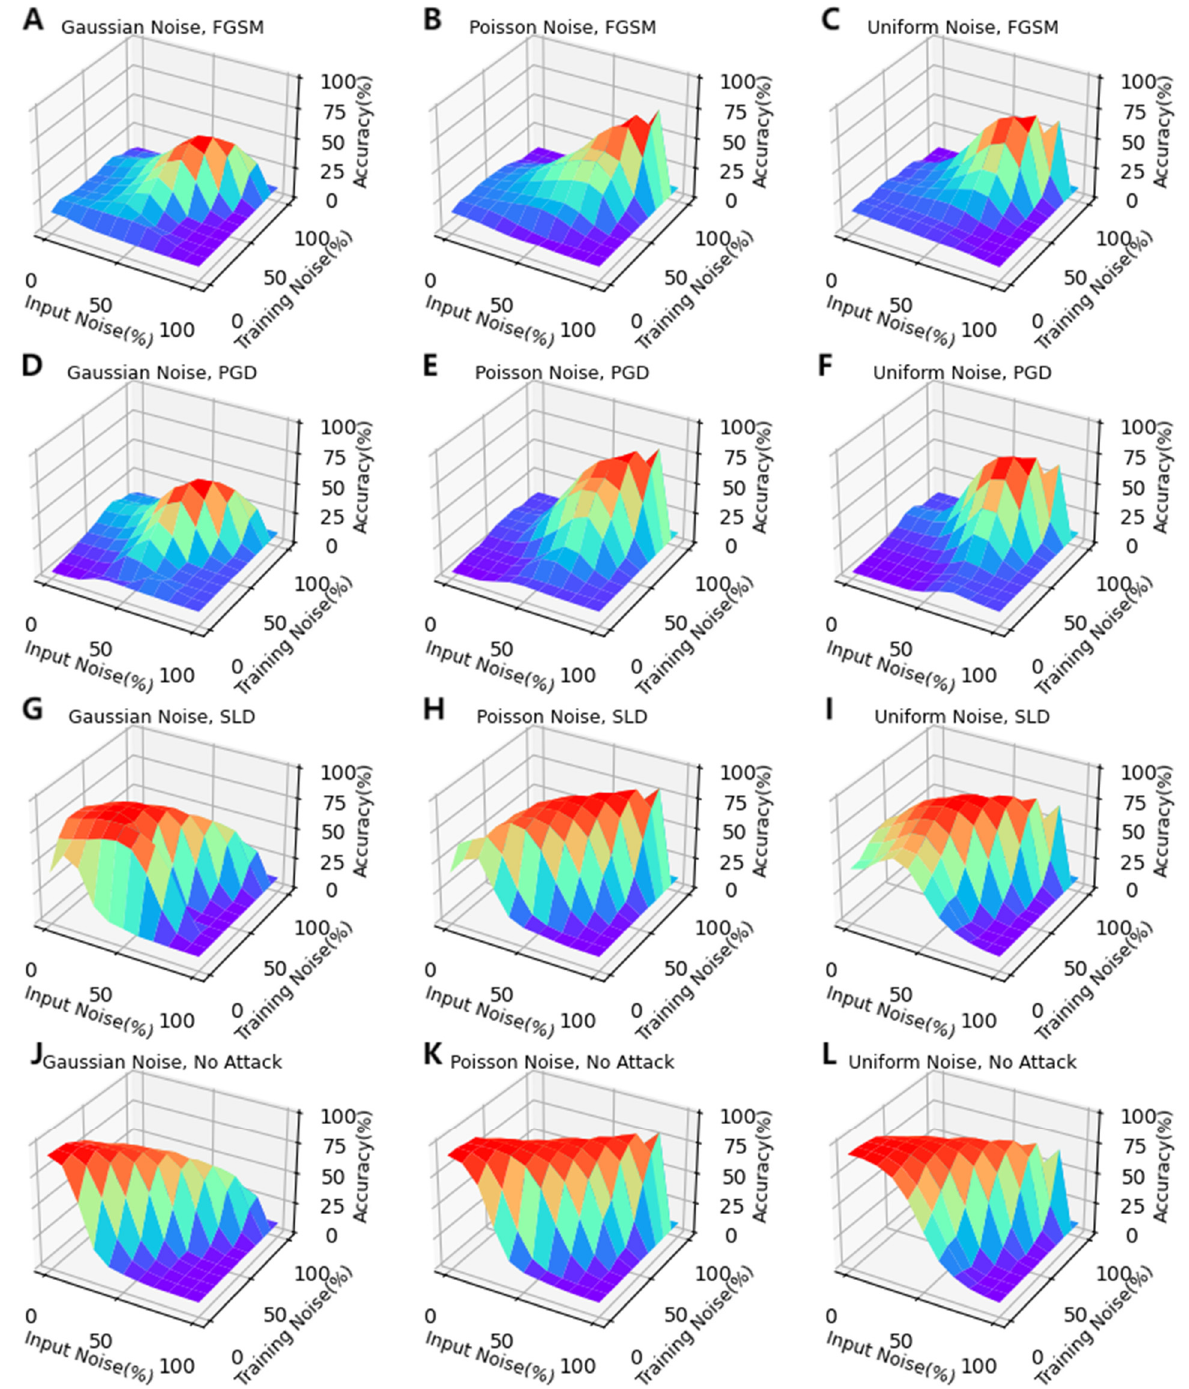
Figure 5. Accuracy of the CIFAR-10. The x and y axes are the amplitudes of the training noise added during training time and the input noise added at running time, respectively. The z axis represents the accuracy of corresponding noise conditions.